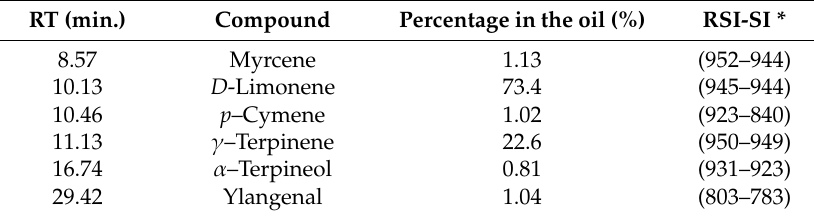
Table 4. Phytochemical composition of C. sinensis essential oil by GC/MS.